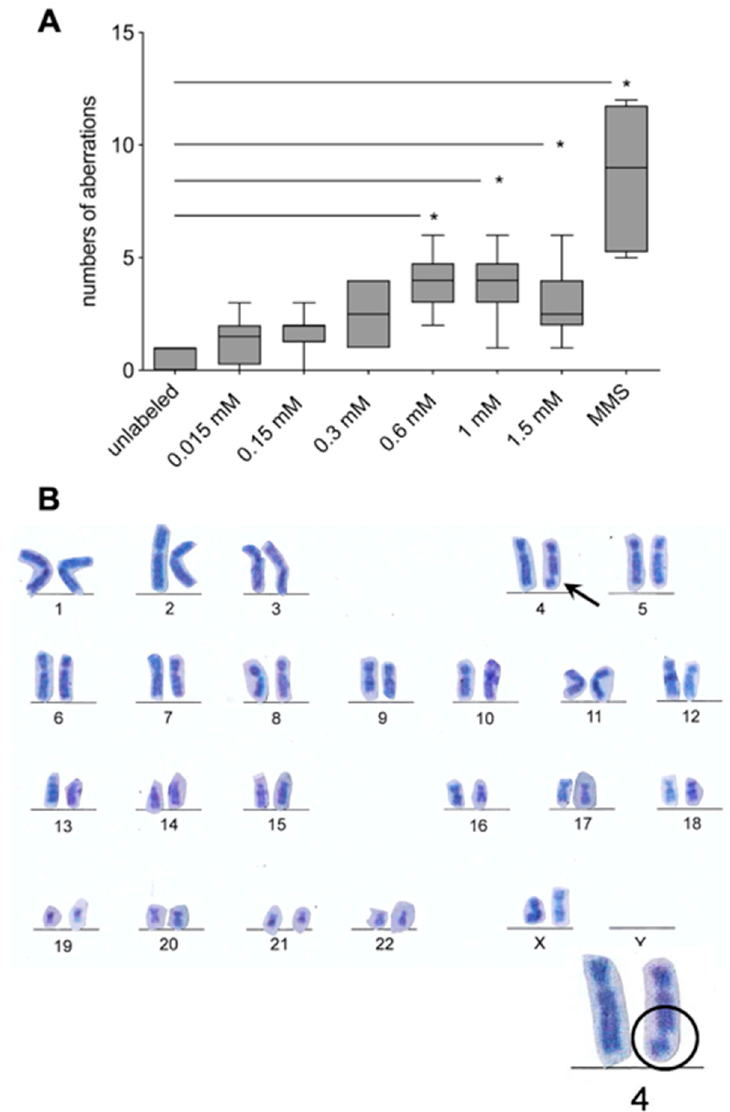
Figure 4. Chromosomal aberration test: ( A ) There was a significant increase in chromosomal aberrations from a concentration of 0.6 mM onwards compared to the unlabeled control (* p < 0.001: 0.6 mM, 1 mM; * p < 0.05: 1.5 mM). Furthermore, there was a significant increase in chromosomal aberrations after exposure of the hASCs to 200 µM MMS (positive control, * p < 0.0001). Significance is indicated by asterisks. ( B ) Chromatid and chromosomal breaks were observed: the example shows a chromatid break of chromosome 4.